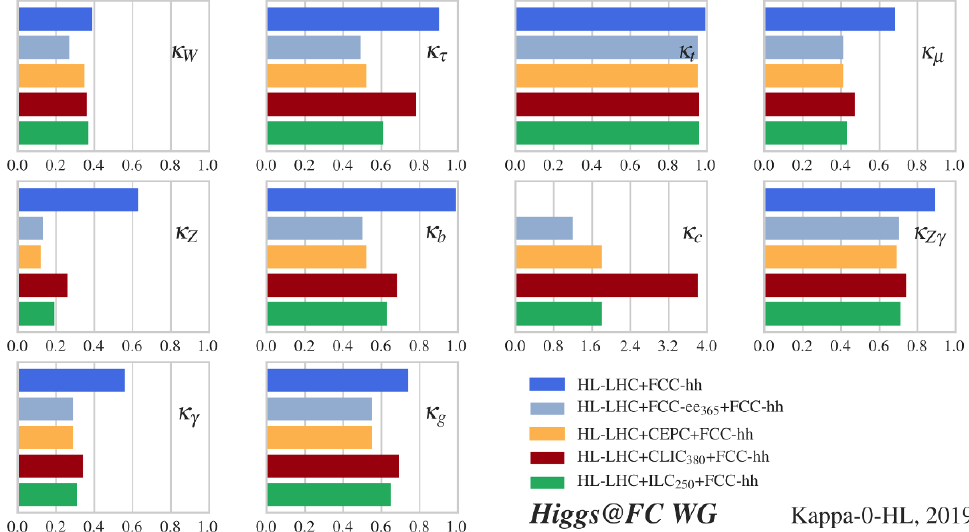
Figure 16 . Combination of the di(cid:11)erent future ee colliders with FCC-hh and HL-LHC, in an extension of the kappa-0-HL scenario. Note that ILC 250 and CLIC 380 ((cid:12)rst stages) are shown in comparison with CEPC (240) and FCC-ee 365